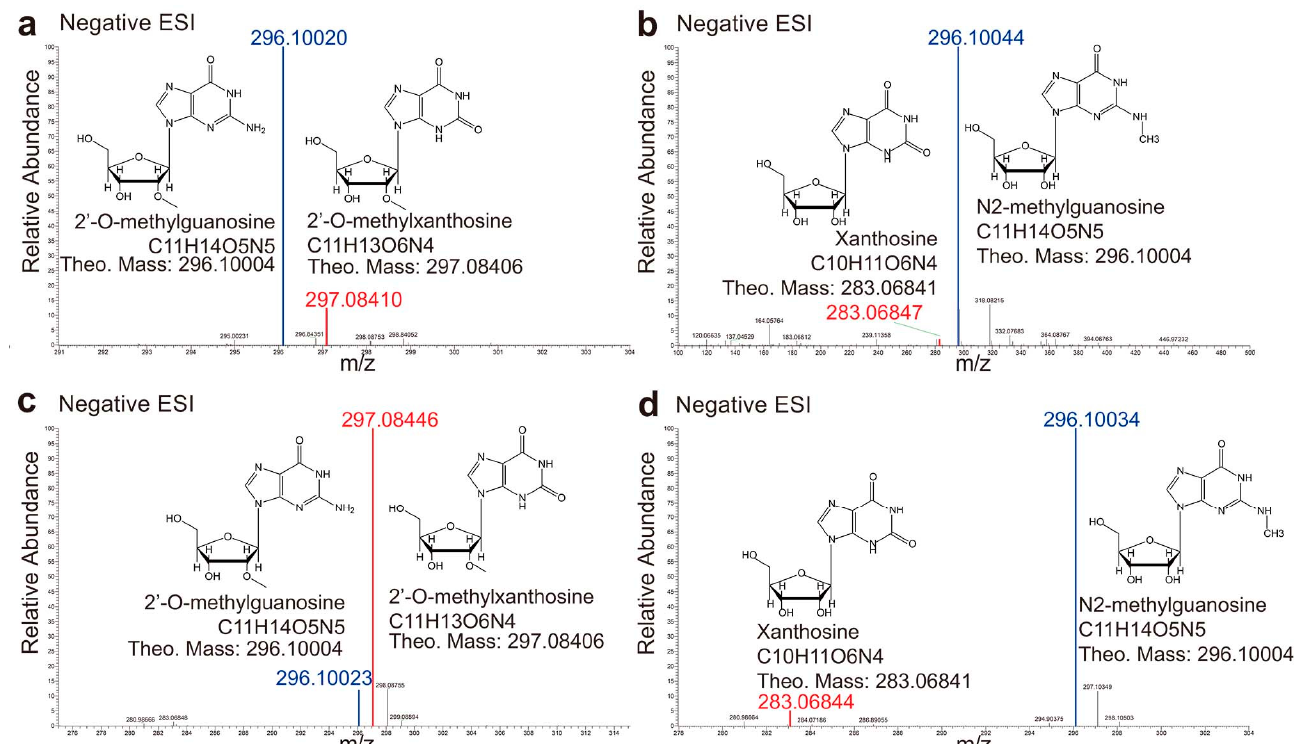
Figure 2. The deamination activity tests of AtGSDA and variants, analyzed by the Orbitrap high- definition mass spectrometry. ( a , b ) The 2-h deamination product by WT-AtGSDA incubation with 2 ′ -O-mG ( a ) and with N 2 -mG ( b ), respectively. ( c , d ) The 24-h deamination product by WT-AtGSDA incubation with 2 ′ -O-mG ( c ), and with N 2 -mG ( d ), respectively. The blue and red lines indicate the substrates and the products, respectively.